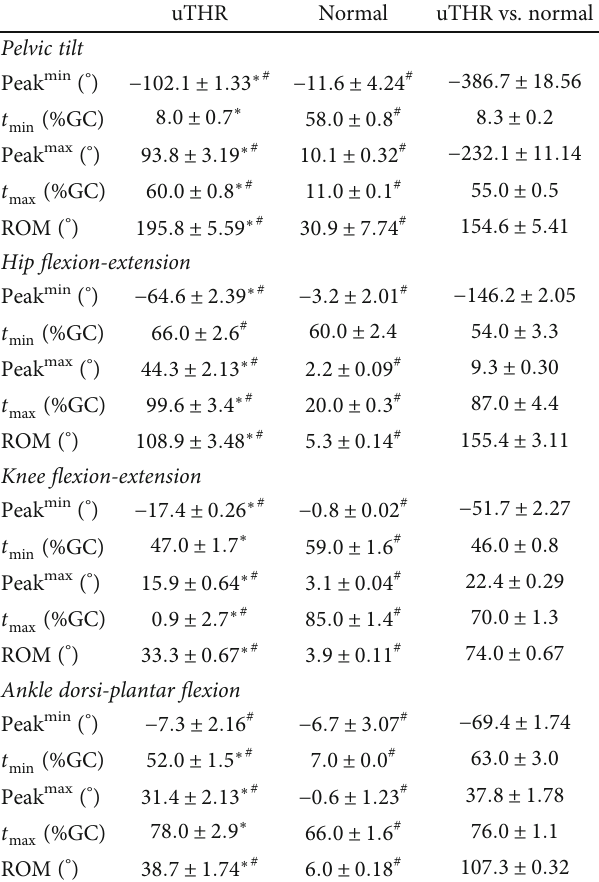
Table 2: Mean ± standard deviation SF for the uTHR and normal groups and between the uTHR and the right normal